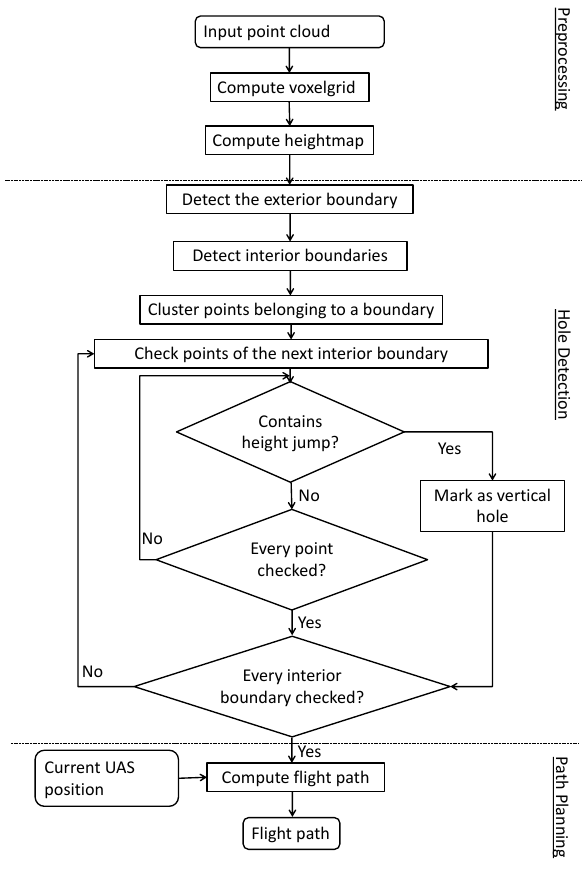
Figure 3. Flowchart for the hole detection and path planning